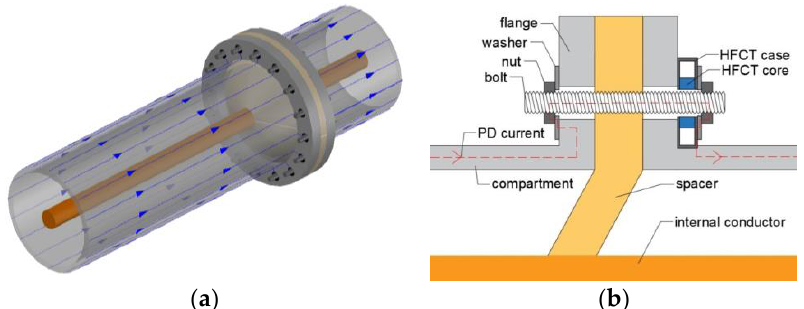
Figure 3. ( a ) Partial discharge (PD) pulse currents as they travel along the GIS; ( b ) PD pulse current flowing along the bolts connecting two compartments.